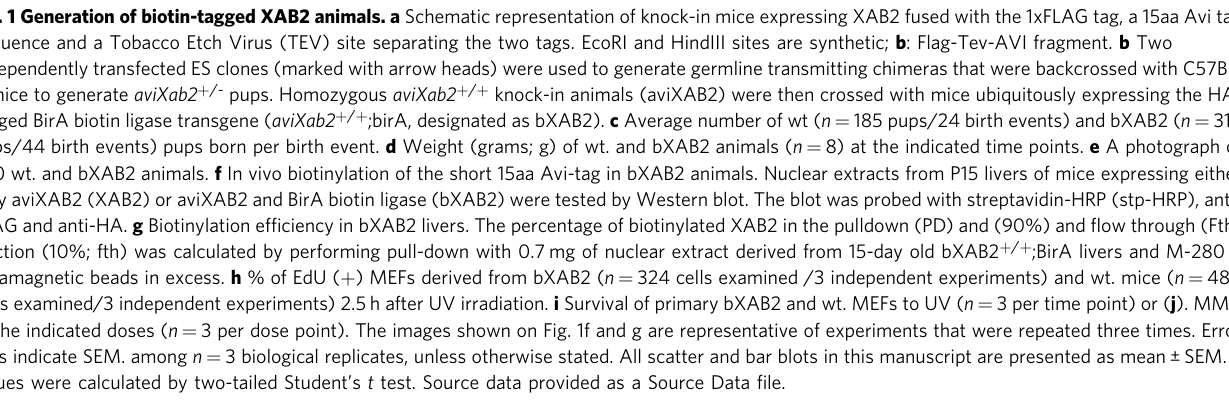
Fig. 1 Generation of biotin-tagged XAB2 animals. a Schematic representation of knock-in mice expressing XAB2 fused with the 1xFLAG tag, a 15aa Avi tag sequence and a Tobacco Etch Virus (TEV) site separating the two tags. EcoRI and HindIII sites are synthetic; b : Flag-Tev-AVI fragment. b Two independently transfected ES clones (marked with arrow heads) were used to generate germline transmitting chimeras that were backcrossed with C57Bl/ 6 mice to generate aviXab2 + /- pups. Homozygous aviXab2 + / + knock-in animals (aviXAB2) were then crossed with mice ubiquitously expressing the HA- tagged BirA biotin ligase transgene ( aviXab2 + / + ;birA, designated as bXAB2). c Average number of wt ( n = 185 pups/24 birth events) and bXAB2 ( n = 319 pups/44 birth events) pups born per birth event. d Weight (grams; g) of wt. and bXAB2 animals ( n = 8) at the indicated time points. e A photograph of P20 wt. and bXAB2 animals. f In vivo biotinylation of the short 15aa Avi-tag in bXAB2 animals. Nuclear extracts from P15 livers of mice expressing